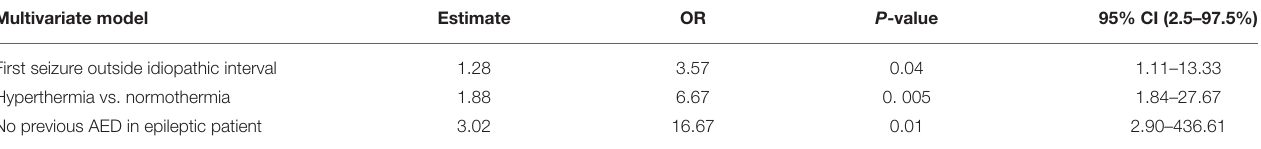
TABLE 2 | Multivariate model. Multivariate